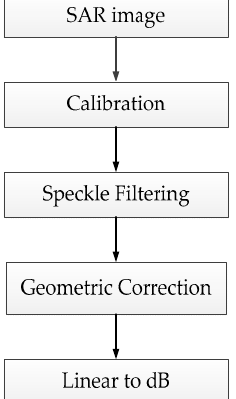
Figure 3. Procedures of Sentinel-1A image preprocessing.